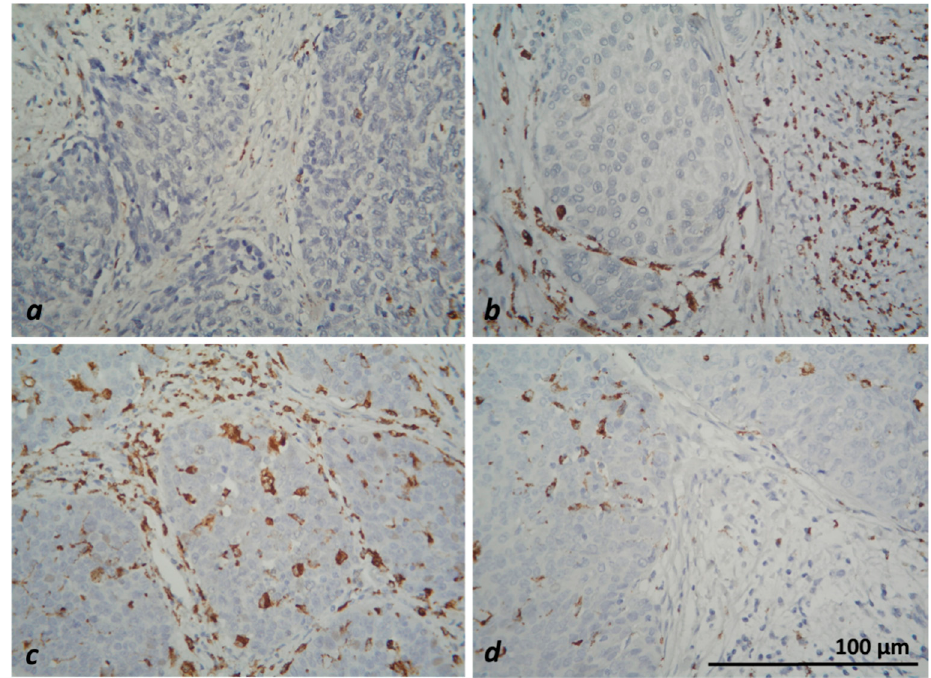
Figure 4. Microscopic evaluation of IHC-stained CD68+ macrophages (colored brownish) in CC—low intratumoral and stromal ( a ), low intratumoral and high stromal ( b ), high intratumoral and stromal ( c ) and high intratumoral and low stromal ( d ) concentration of positive cells, ×400.